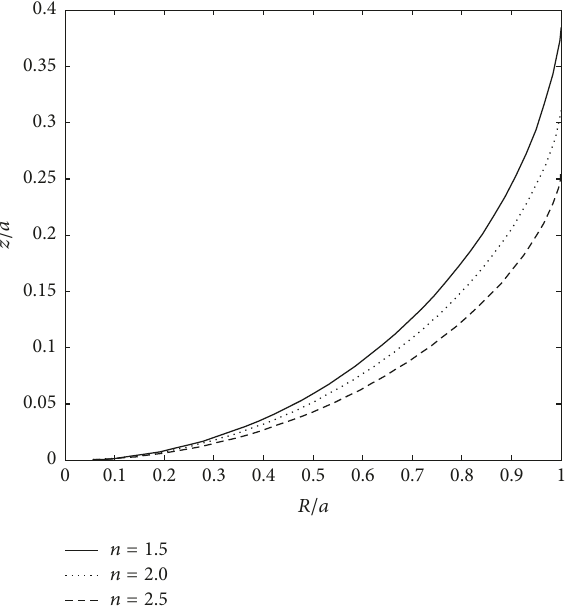
Figure 9: The radical stress distribution on membrane ( 𝑞/𝐴 = 10 ; 𝛼 = 0.6 ).